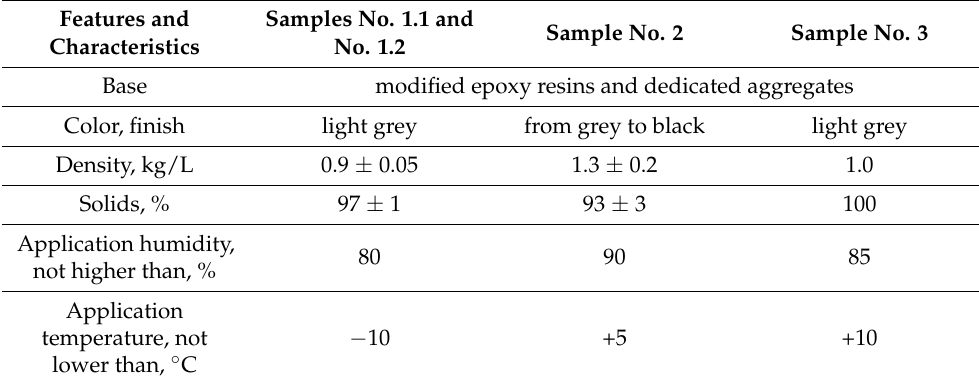
Table 1. Features and characteristics of the researched fireproofing